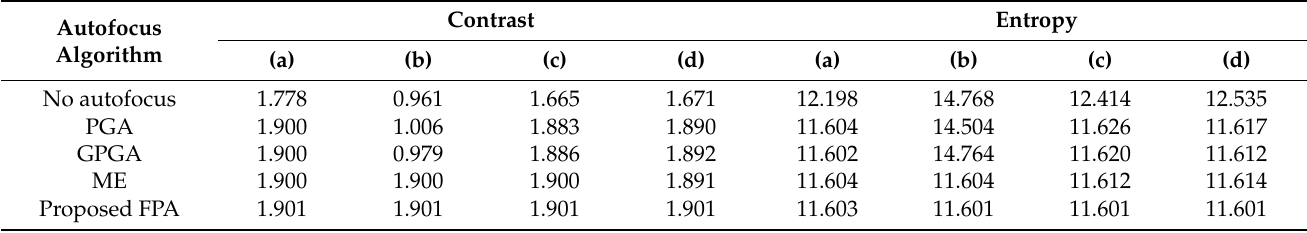
Table 2. Comparison of performance for different autofocus algorithms.